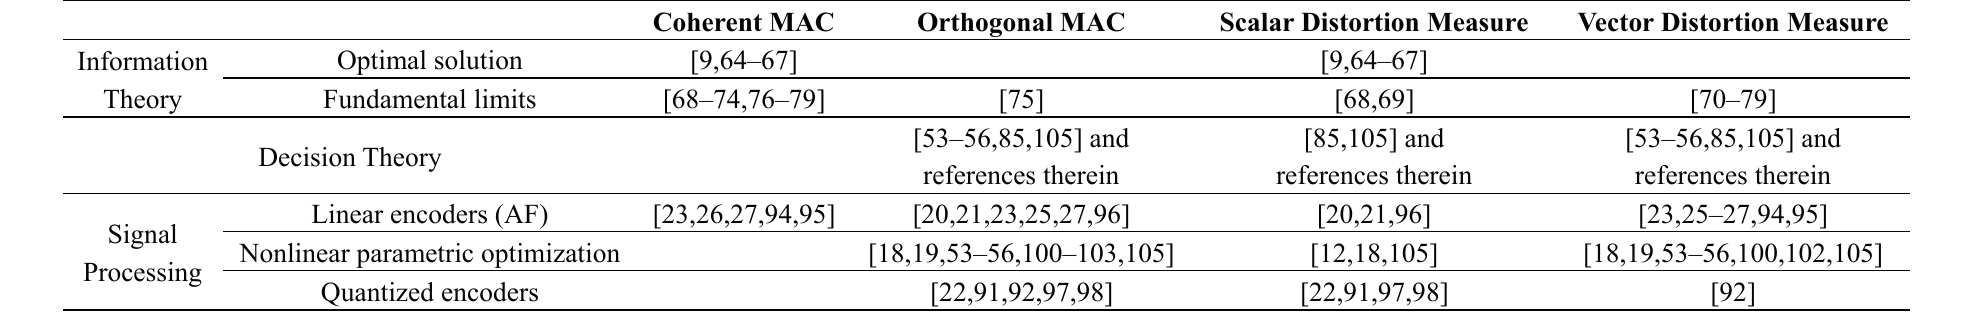
Table 1. Classification of different WSN approaches (in the setting studied in this paper) in the